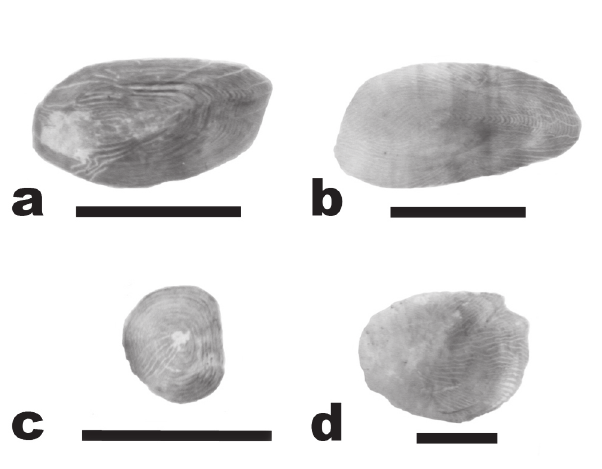
Fig. 10. Scale shape above the lateral line at about two thirds of body. ( a ) Iracema caiana , MZUSP 49205; ( b ) Rhamphichthys marmoratus , MZUSP 49205; ( c ) Gymnorhamphichthys rosamariae , MCP 24359; and ( d ) Hypopomus artedi , ANSP 177489. Lateral view of left side. Anterior to left. Scale bar is 1 Color in Alcohol. Background color pale yellow, dorsolateral and lateral surfaces of head and body darker. Head almost unpigmented ventrally except for dark chromatophores on anterior portion of lower jaw. Dorsal portion of head and temporal region strongly pigmented, forming dark brown speckles from snout to nape region; speckles of about eye size; most concentrated dorsolaterally and absent on dorsal midline of head. Lateral region of body yellow with dark reddish and diffuse chromatophores. Anal-fin pterygiophore region lighter than other parts of body. Scattered dark brown speckles over anal-fin pterygiophores. About 20 to 30 dark brown diffuse blotches on lateral surface of body. Caudal appendage pale yellow, except for diffuse dark brown bands not extending to dorsal or ventral midline. Distal third of caudal appendage pale yellow, not darkly pigmented. Pectoral- fin membranes mostly hyaline with scattered chromatophores at distal end; anal-fin membrane hyaline except for dark brown band covering entire extent of distal two-thirds of rays. Iridescent coloration throughout entire lateral portion of body.